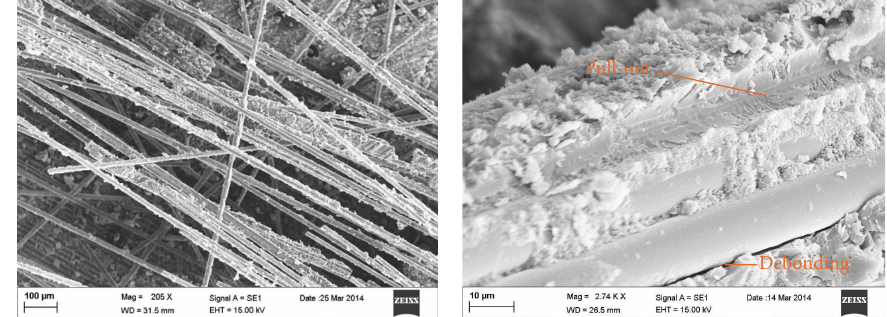
Figure 8: The SEM images of the SMC composite filled with CaCO 3 .